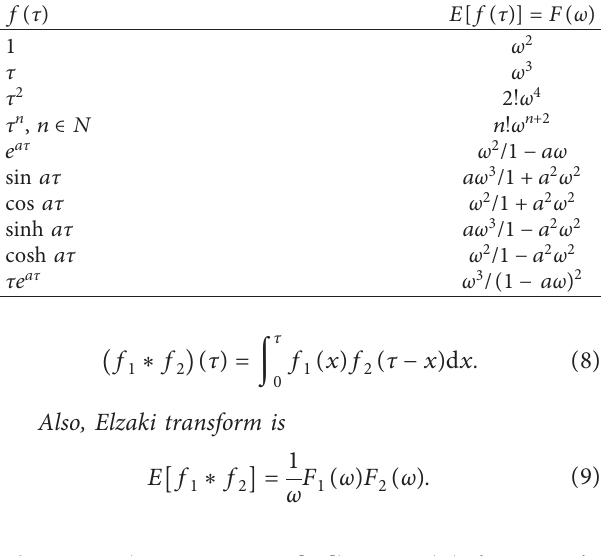
Table 1: Special functions by transform of